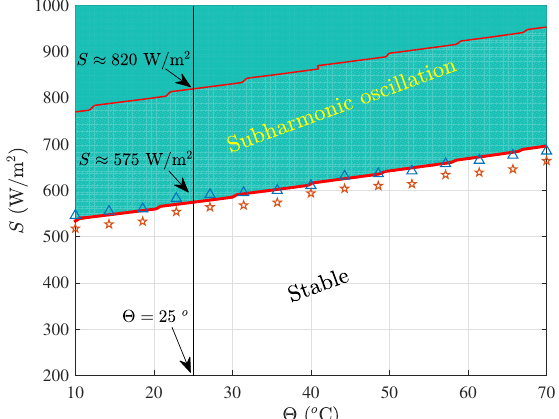
Figure 17. The subharmonic instability boundary in the parameter plane ( Θ , S ). The results are obtained from the theoretical expression (41) with L 1 and L 2 fixed (thin curve), with L 1 and L 2 varied according to (42) (thick curve), from computer simulations performed on the switched model with L 1 and L 2 varied according to (42) ( ), and experimentally ( (cid:63) ). V M = 4 (cid:52)